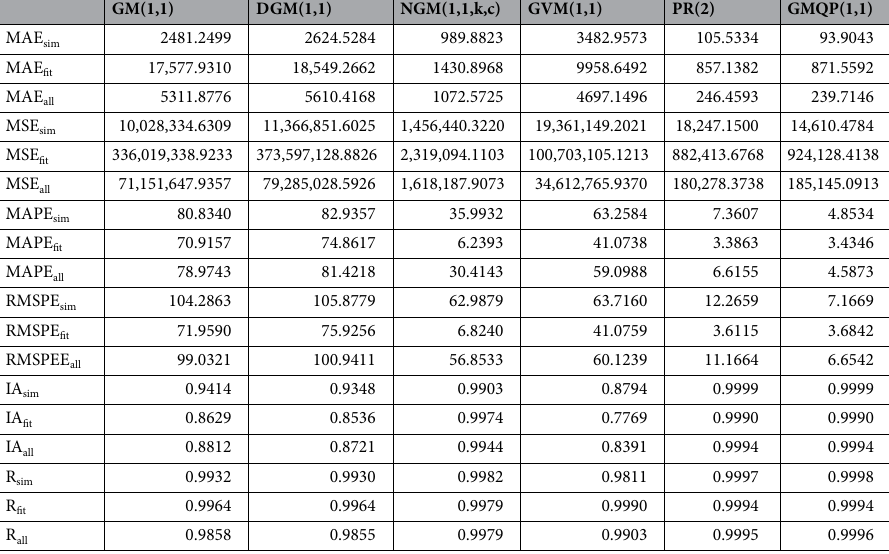
Table 11. The evaluation measures of different forecasting models in the confirmed